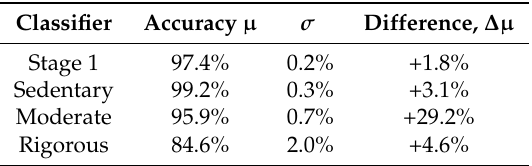
Table 6. On-board Classification (engaging the